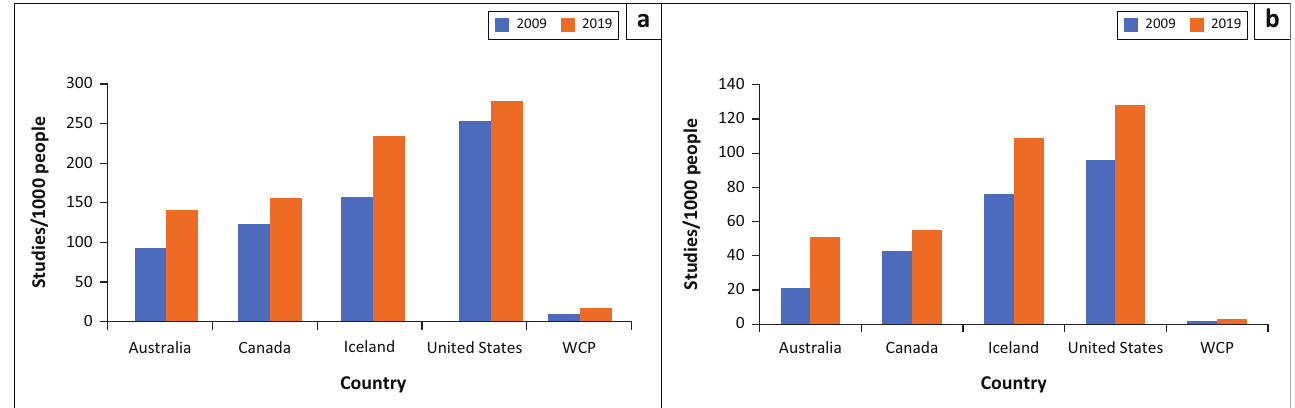
FIGURE 1 : Comparison of Western Cape Province imaging trends with published international trends, 2009–2019. (a) Comparison of computed tomography utilisation, (b) comparison of magnetic resonance imaging